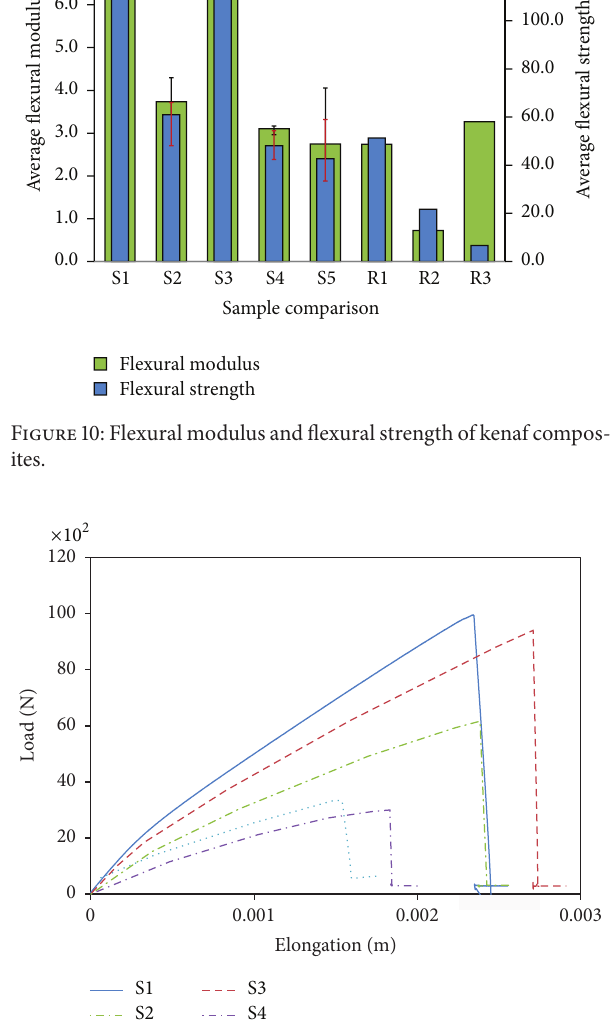
Figure 9: Flexural-stress-strain curves for kenaf composites.